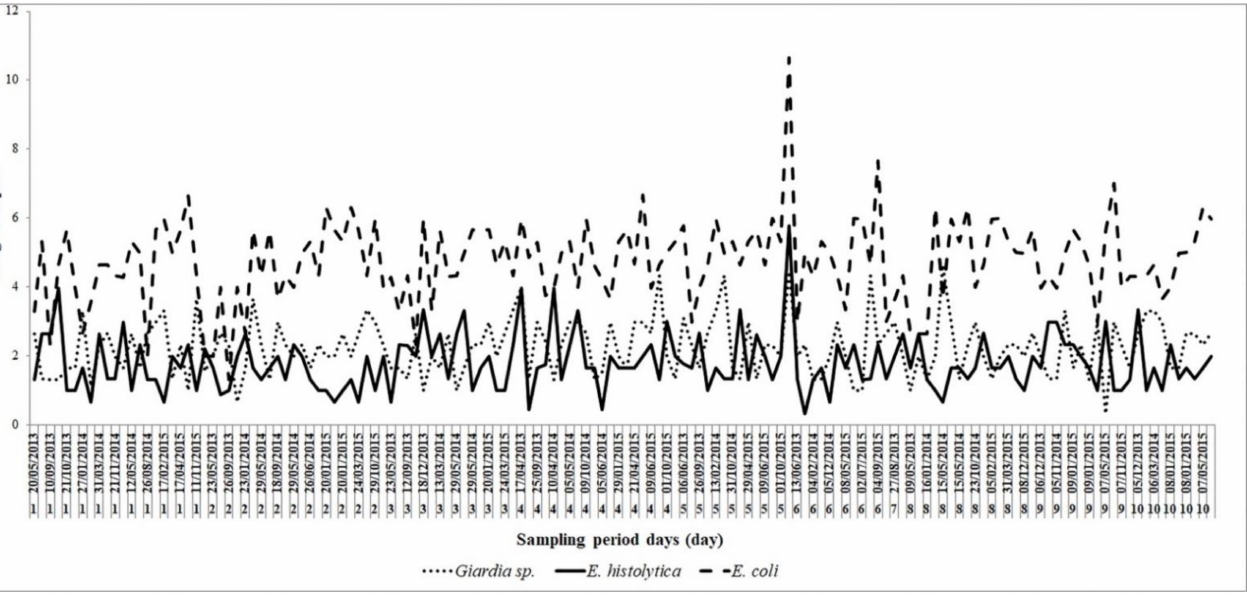
Figure 6. Protozoan cyst concentration (per 100 g DM) by Arther’s technique in dried sludge dewatered in beds at solar exposure from the ten WWTPs (1–10) during 2013–2015. Mean helminth egg concentration during the three-year study for all WWTPs was ≤ 1 egg/100 g